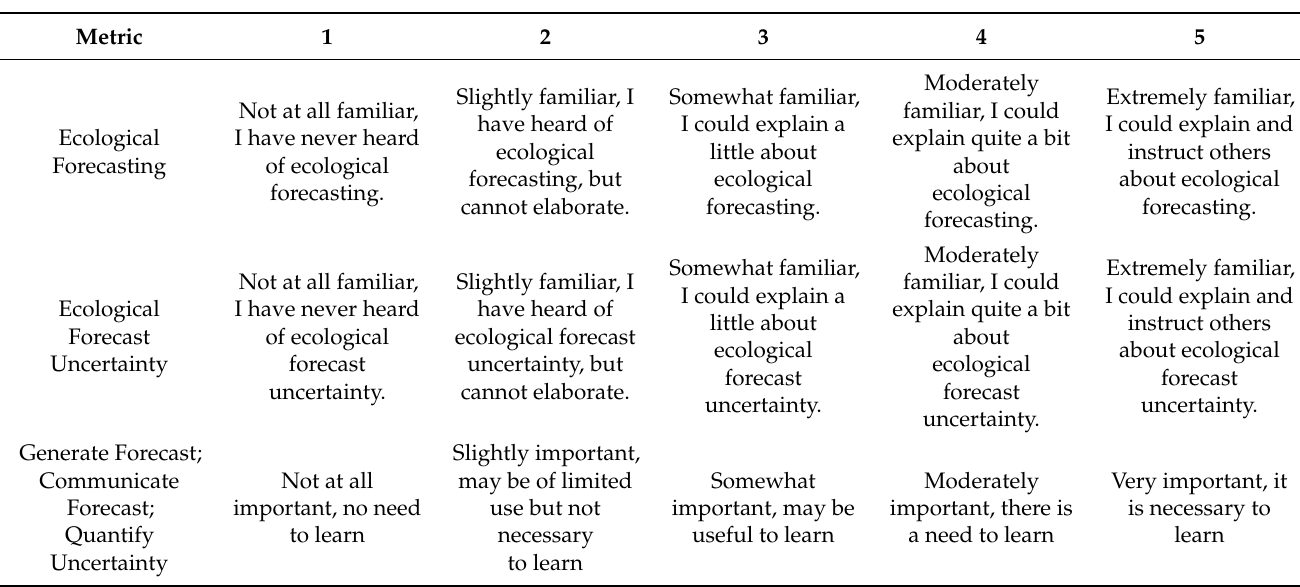
Table A4. Free-form assessment question (Q5) for pre- and post-module responses for the module.